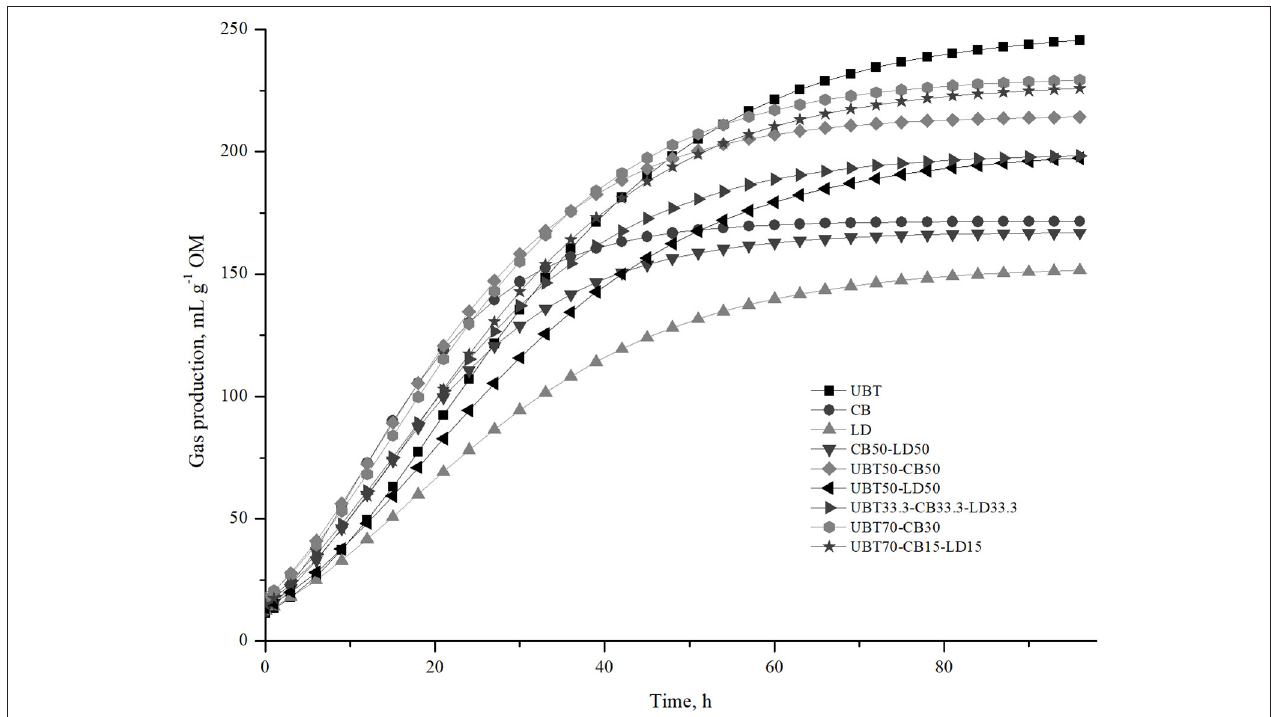
FIGURE 2 | Accumulated gas production (AGP; mL g − 1 OM) for UBT, CB, LD, mixed diets. UBT, Toledo 100%; CB, Canavalia 100%; LD, Leucaena 100%; CB50LD50, Canavalia 50% + Leucaena 50%; UBT50CB50, Toledo 50% + Canavalia 50%; UBT50LD50, Toledo 50% + Leucaena 50%; UBT33.3CB33.3LD33.3,